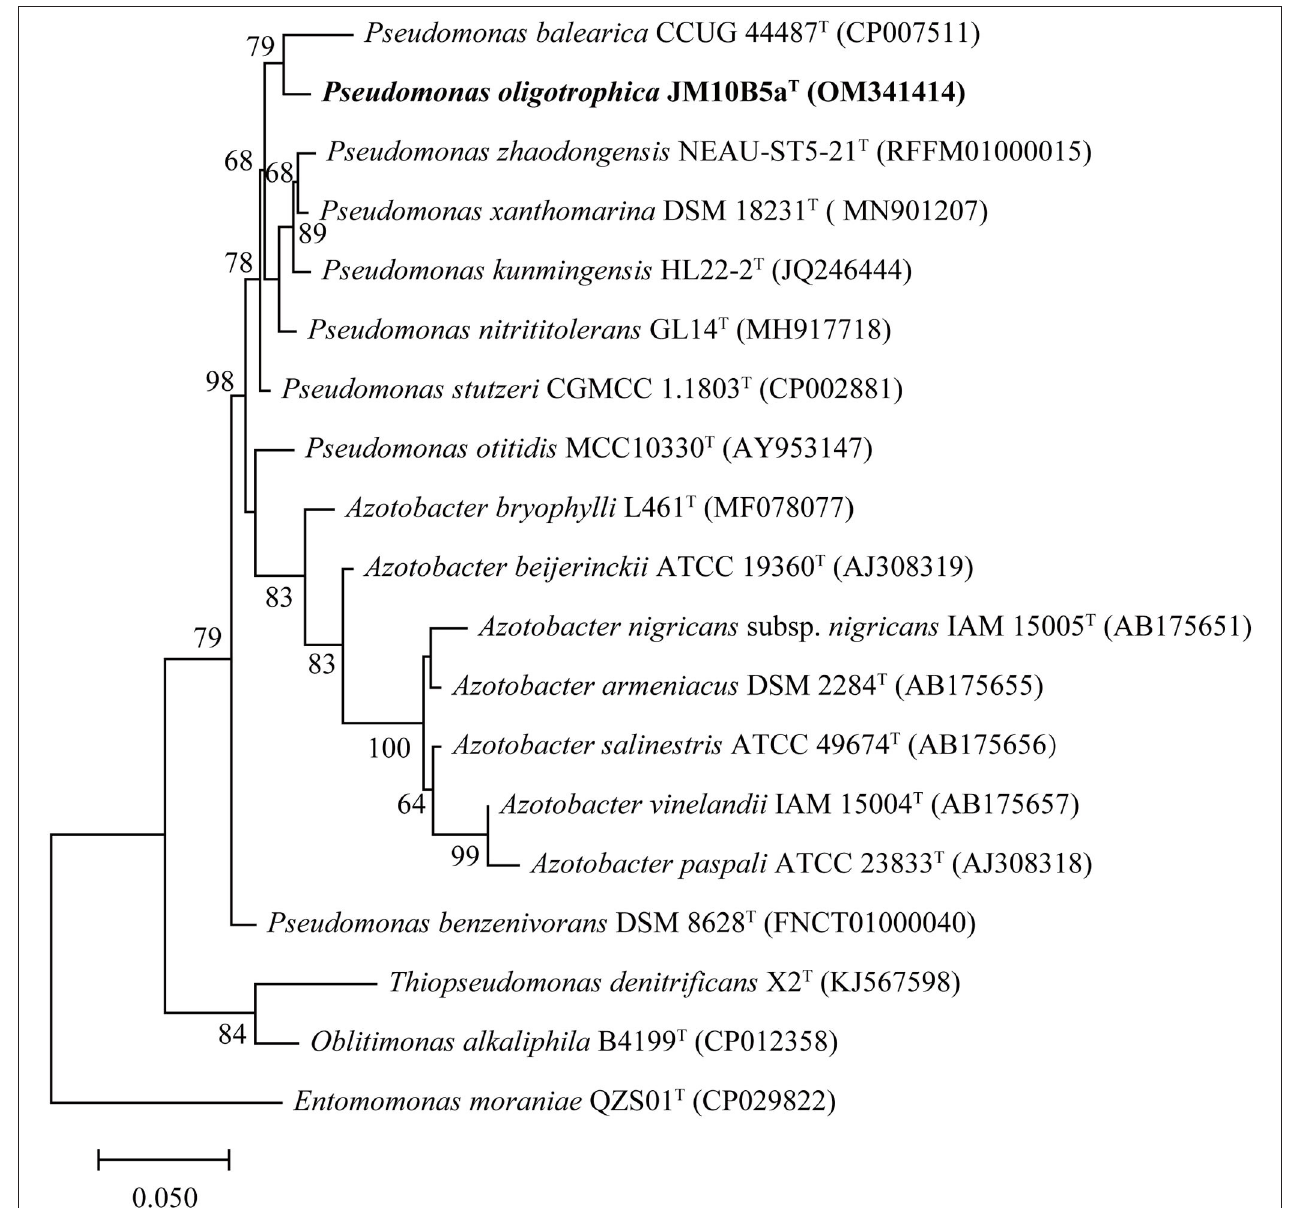
FIGURE 1 | ML tree based on 16S rRNA gene sequences of strain JM10B5a T and the related type strains of genus Pseudomonas . Type strain Entomomonas moraniae QZS01 T was used as an outgroup. There were a total of 1,303 positions used to construct the phylogenetic tree. Bootstrap values higher than 60% were shown at branch points. Bar, 0.05 represents the number of substitutions per